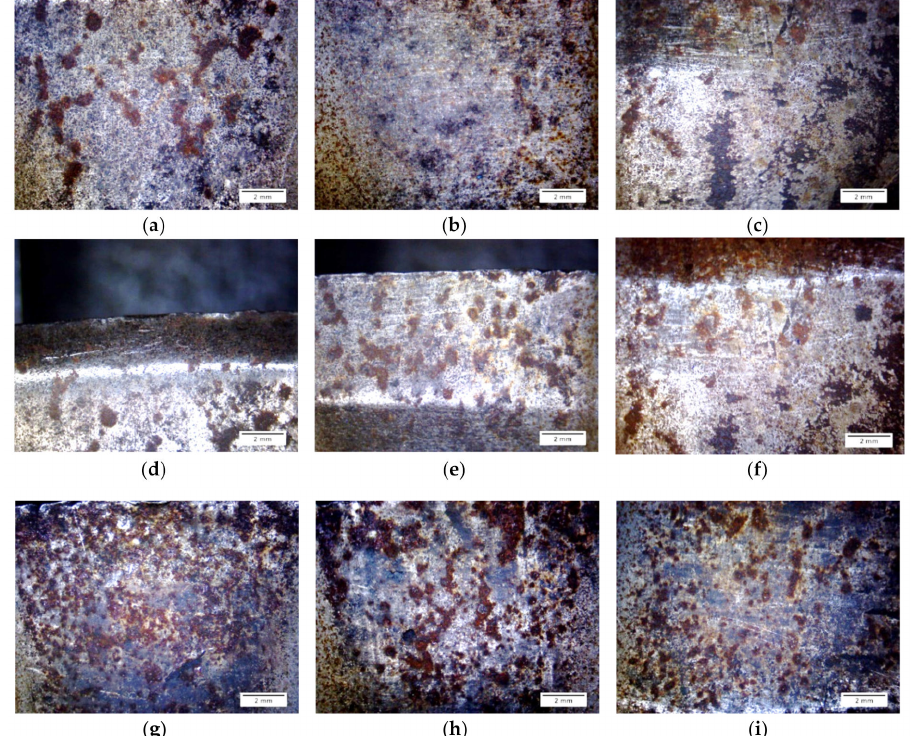
Figure 10. Observation of threshold abrasion surfaces with a macro lens. On side A of the samples. ( a ) First row; ( b ) Third row; ( c ) Fifth row. On side AB of the samples. ( d ) First row; ( e ) Third row; ( f ) Fifth row. On side B of samples. ( g ) First row; ( h ) Third row; ( i ) Fifth